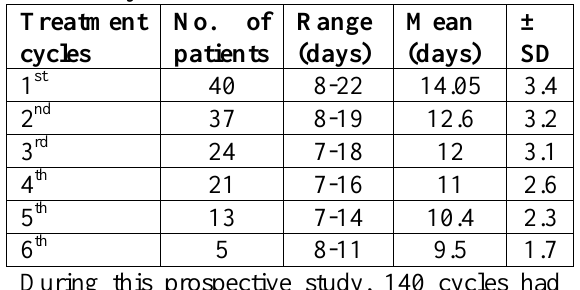
Table-3: Duration of treatment in